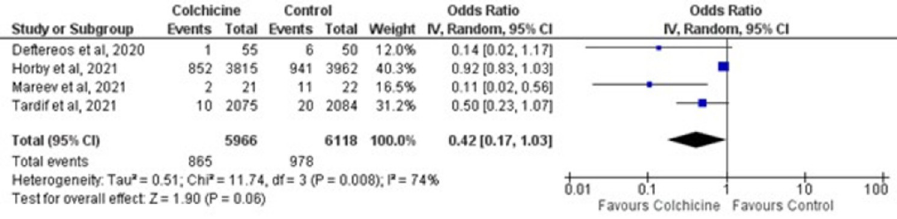
Fig 4. Forest plot for effects of colchicine on mechanical ventilation in COVID-19 patients. Blue squares and their corresponding lines are the point estimates and 95% confidence intervals per each study. Black diamonds represent the pooled effect